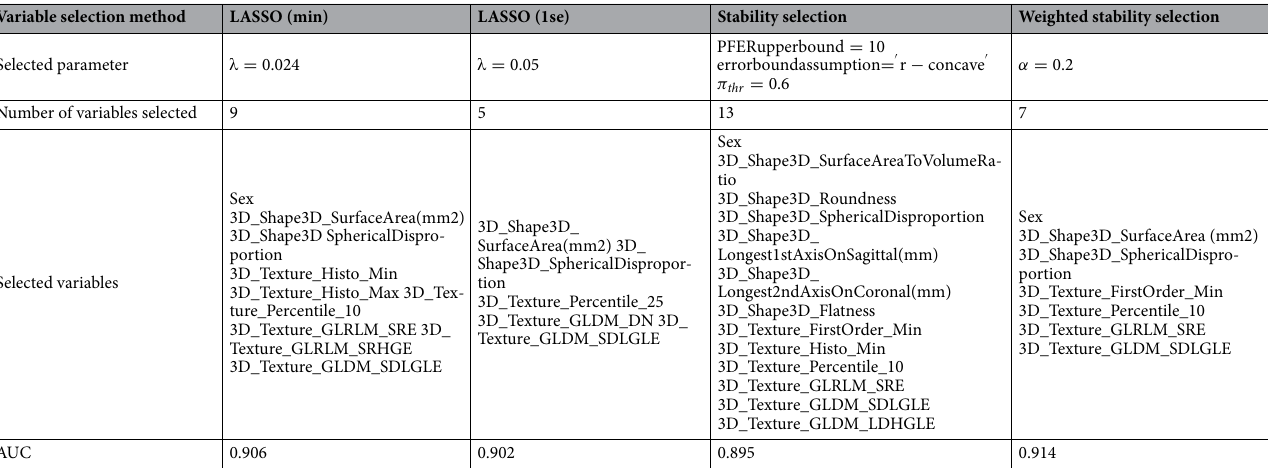
Table 1. Results of variable selection for four different methods using radiomics data on aortic valve